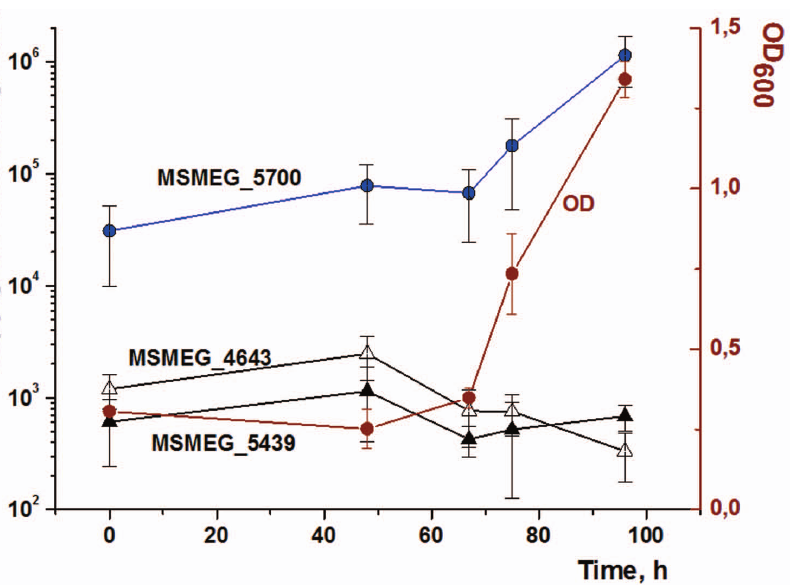
Figure 9. Expression profiles of three M.smegmatisrpf genes during oleic acid-mediated resuscitation of NC cells. NC cells were resuscitated in batch mode. Oleic acid was added at a concentration of 3.5 m M and the initial culture density was adjusted to give an OD 600 =0.3. RNA was isolated from cells withdrawn from the culture at different time points. Quantitative RT-PCR was performed using equal amounts of RNA (50 ng) as described in Materials and Methods. Each point is the mean of nine measurements (three technical replicates of the three biological replicates). The average OD 600 values of the three replicate cultures are also shown. Error bars represent the standard error of the mean. Significance between expression level of MSMEG_5700 after 67 h of incubation was demonstrated by ANOVA (P ,